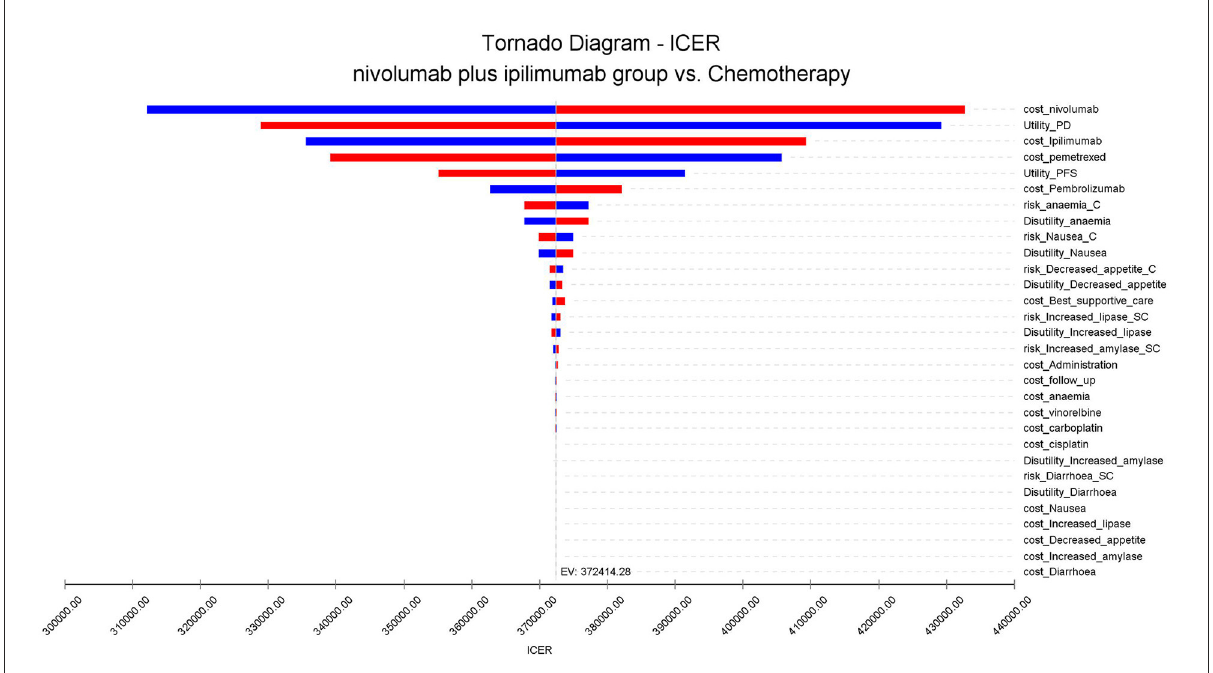
FIGURE1 Tornado diagram for one-way sensitivity